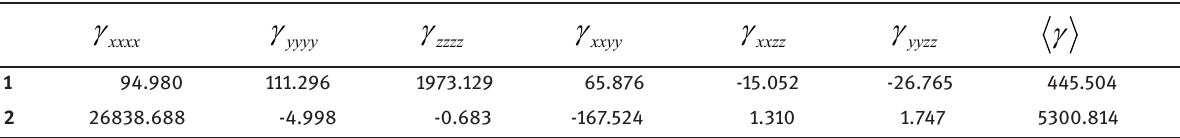
Table 2: All static )0,0,0;0( γ components and )0,0,0;0( γ